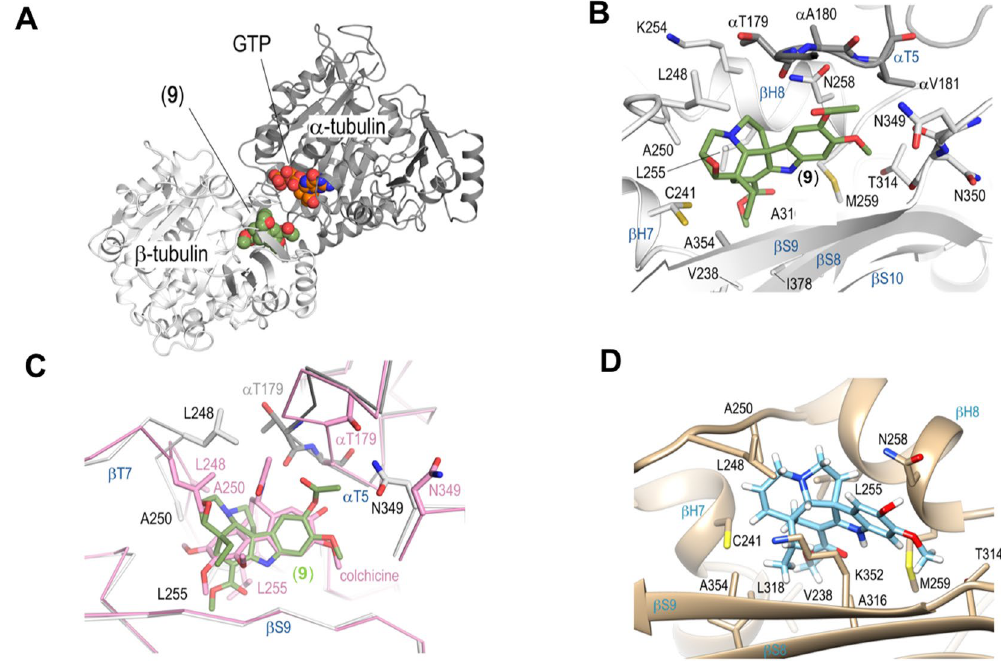
Figure 5. Crystal structure of the tubulin-jerantinine B acetate ( 9 ) complex. ( A ) Overall view of the T 2 R- TTL-jerantinine B acetate complex structure. The α - and β -tubulin chains are in dark and light grey ribbon representation, respectively. The tubulin-bound 9 and GTP molecules are represented as green and orange spheres, respectively; ( B ) Close-up view of the interactions observed between 9 (green) and tubulin (grey). Interacting residues of tubulin are shown in stick representation and are labelled. Oxygen and nitrogen atoms are coloured red and blue, respectively; carbon atoms are in green 9 or grey (tubulin). Secondary structural elements of tubulin are labelled in blue. For simplicity, only α -tubulin residues are indicated with an α ; ( C ) Superimposition of the tubulin- 9 (green/grey) and the tubulin-colchicine (pink; PDB ID 4O2B; rmsd of 0.204 Å over 351 C α -atoms) complex structures. The structures were superimposed onto their β 1-tubulin chains; ( D ) Molecular docking of ( − )-jerantinine A ( 1 ) in the colchicine binding pocket of tubulin; this pocket is formed by residues in the α T5-loop on α -tubulin, and β H7, β H8, β S8, β S9 and the β T7-loop on β -tubulin. For additional experimental details see the Supporting